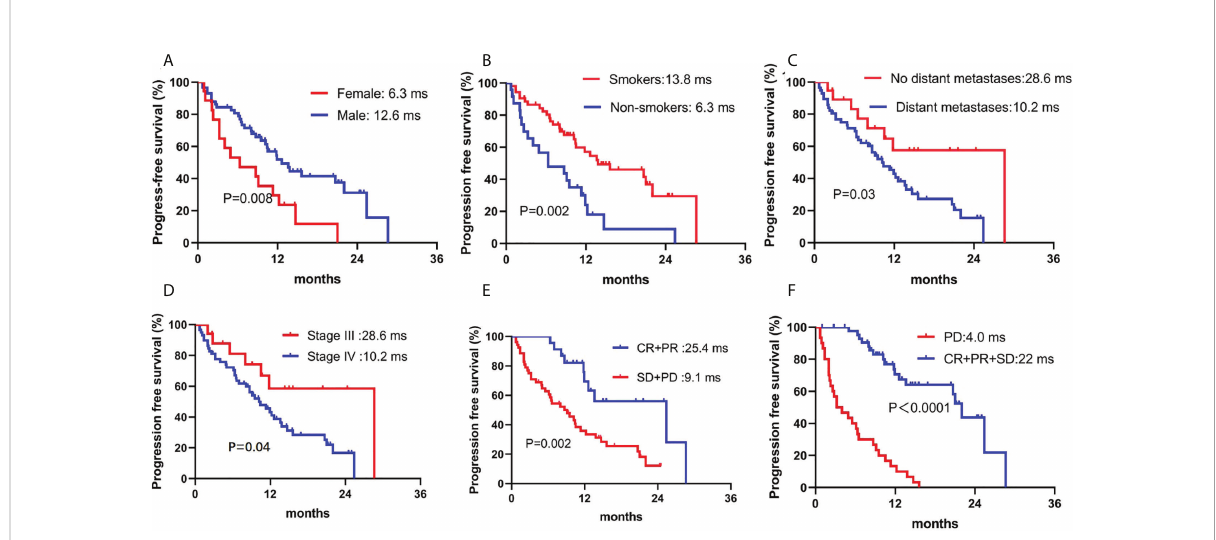
FIGURE 3 Correlation between PFS and (A) sex, (B) smoking history, (C) distant metastases, (D) stage, (E) ORR, and (F) DCR. PFS: progression-free survival; ORR, overall response rate; DCR, disease control